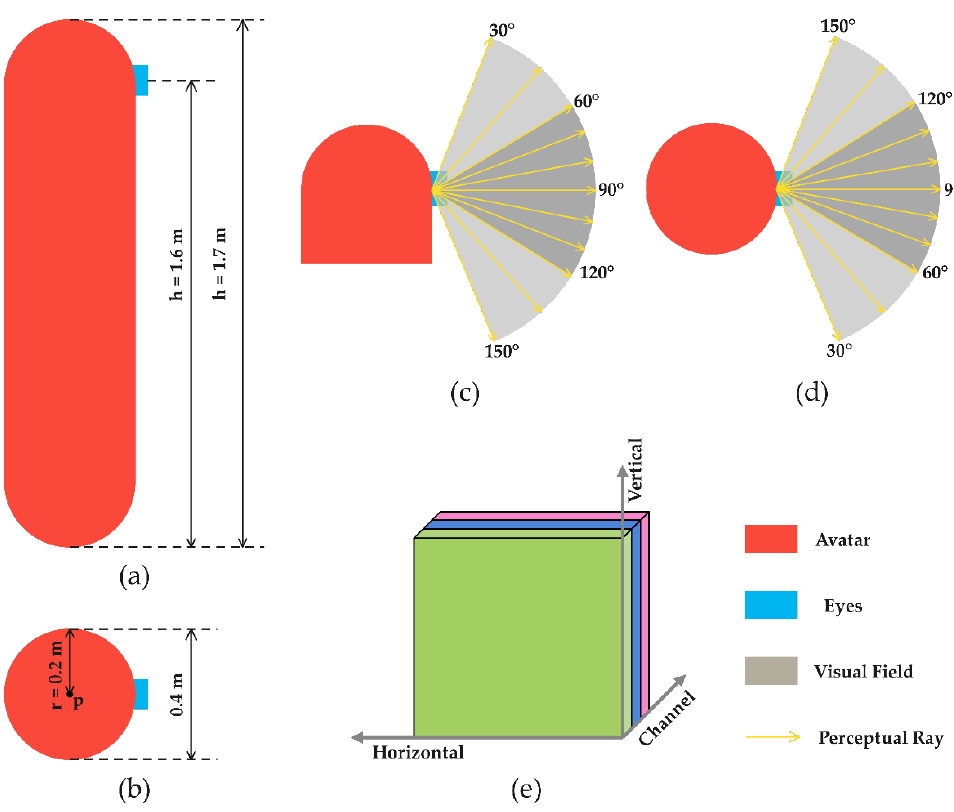
Figure 2. Models of the avatar and perceptron. ( a ) Left view of the avatar; ( b ) top view of the avatar; ( c ) vertical field of the agents’ view; ( d ) horizontal field of the agents’ view; ( e ) matrix of all environmental information obtained by perceptual rays.